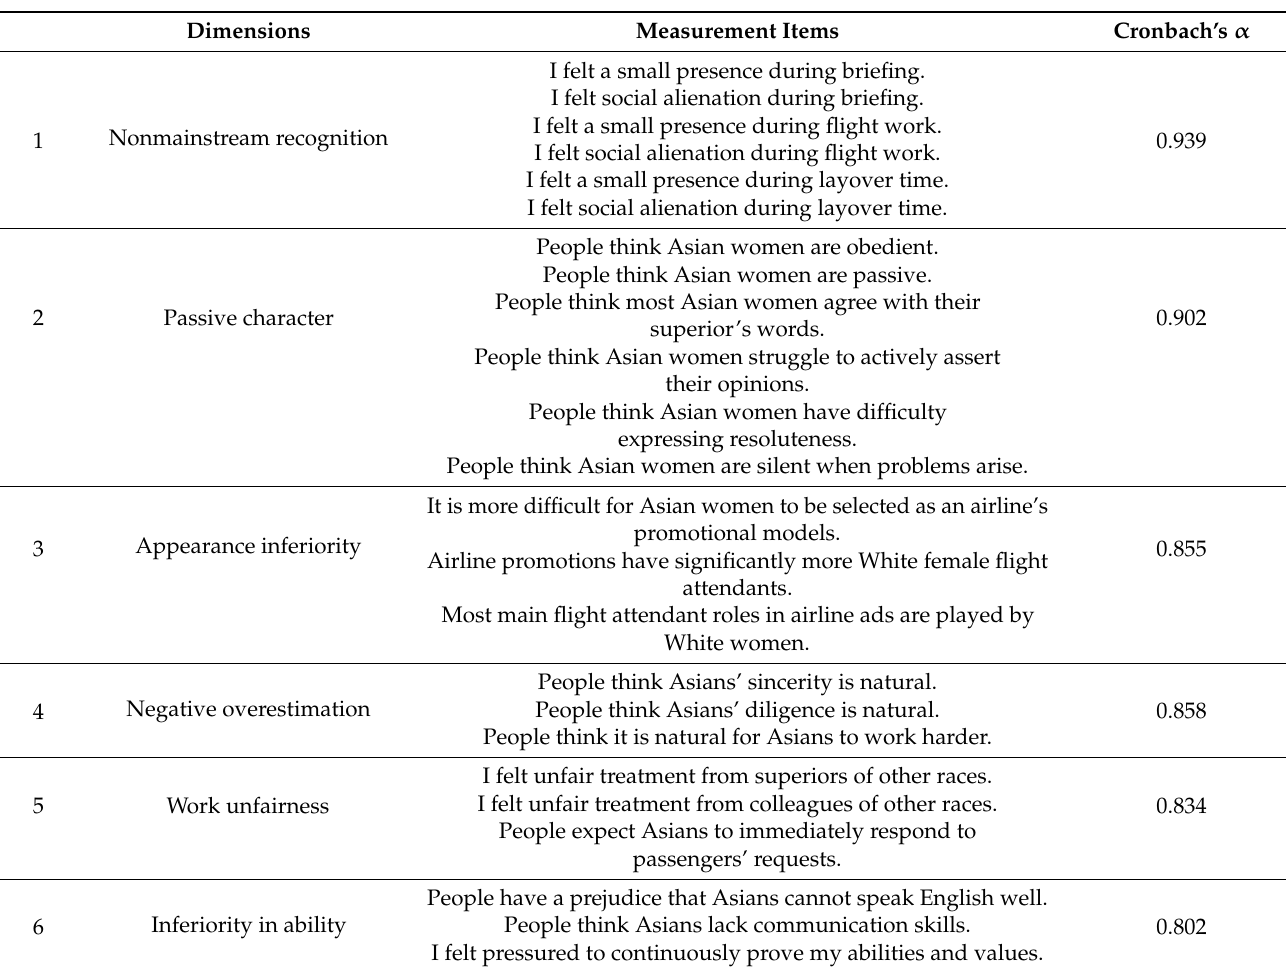
Table 9. Modern racism scale in global